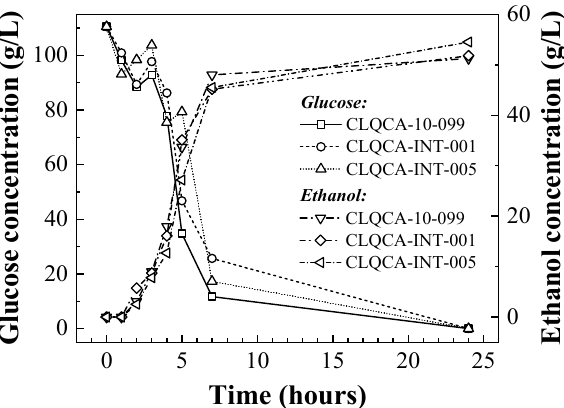
Figure 5. Concentrations of glucose (left) and ethanol (right) during the fermentation process for the best three S. cerevisiae strains. Conditions: 34 °C with stirring at 150 rpm for 24 h. Plotted values correspond to average values across three replicates. Standard deviations were <5.2% in all cases, and generally <2% (error bars are not shown because of the small standard deviation values).